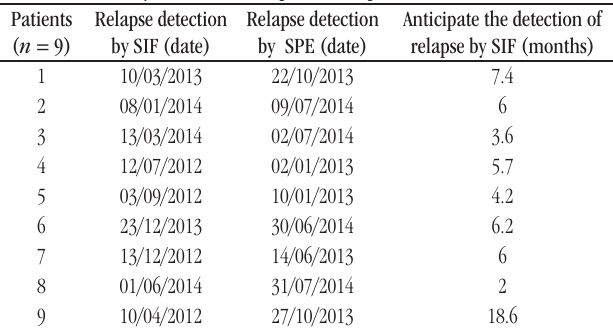
taBLE 2 − Comparison between SIF and SPE techniques for sensitivity in the early detection of relapse in nine patients with MM Patients Relapse